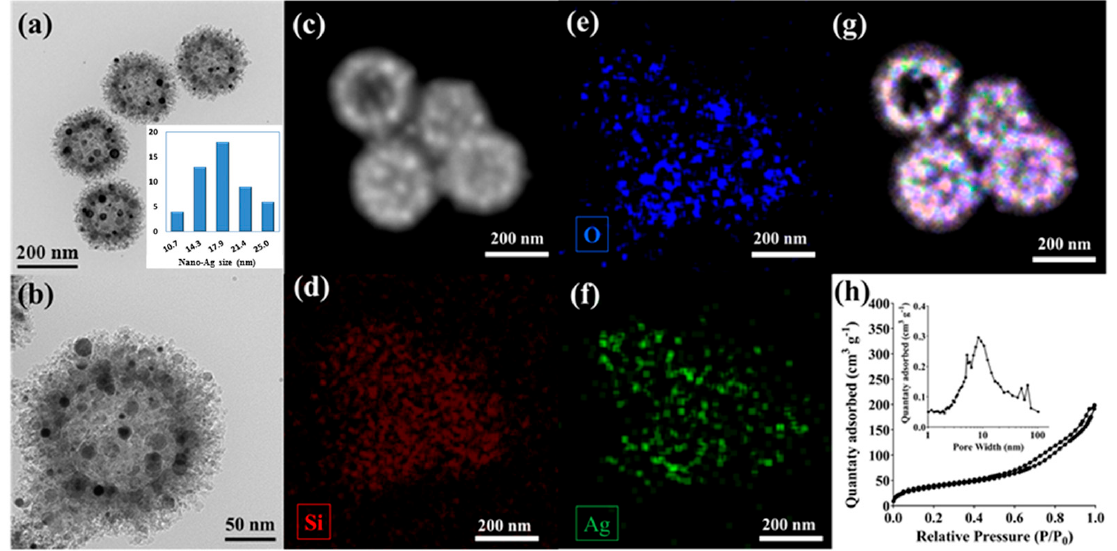
Figure 1. TEM images ( a , b ), with nano-Ag particle size distribution as inset of ( a ), dark field image ( c ), corresponding elemental mapping on silicon ( d ), oxygen ( e ), silver ( f ), Si-Ag-O merged image ( g ), and nitrogen sorption isotherm and ( h ), inset of pore size distribution for SiNPs-Ag.